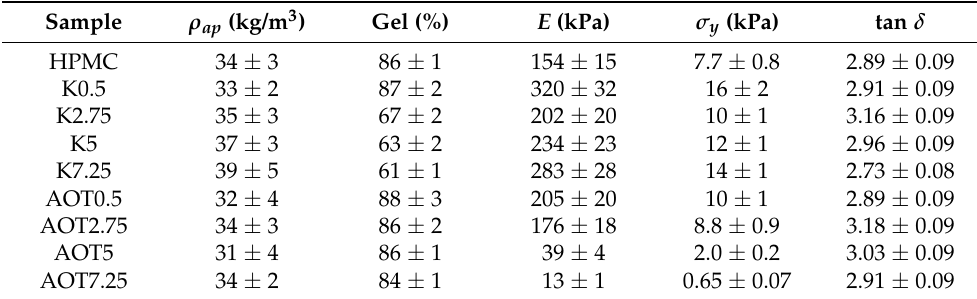
Table 2. Mean values ( n > 4) of apparent density ( ρ ap ), gel content (Gel%) in MilliQ water, Young’s moduli (E), and yield stress ( σ y ) obtained for all cryogels. tan δ (G (cid:48)(cid:48) /G (cid:48) ) determined by SAOS at 0.1 Hz for the precursor